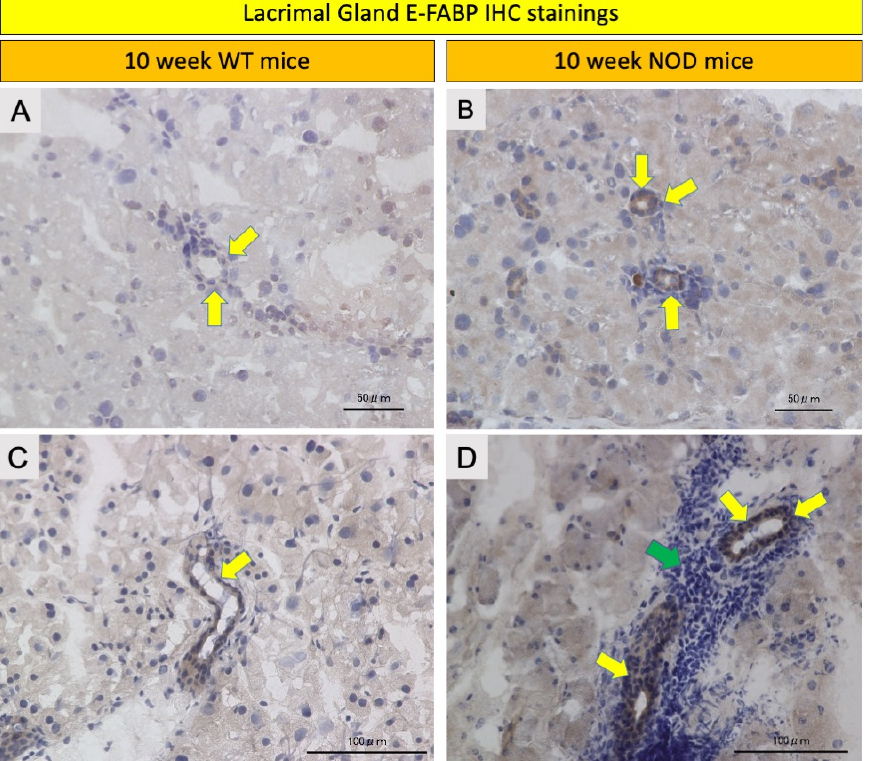
Figure 5. Comparison of E-FABP immunohistochemistry in the lacrimal glands of the wild-type (WT) mice and the NOD mice. Representative immunohistochemistry images showed increased immunostaining of the acinar epithelium in the NOD mice ( B , D ) compared to the WT mice ( A , C ) (yellow arrows). Moreover, a denser infiltration of inflammatory cells around the acinar units of the NOD mice compared to the WT mice can be observed (green arrow). IHC: immunohistochemistry.